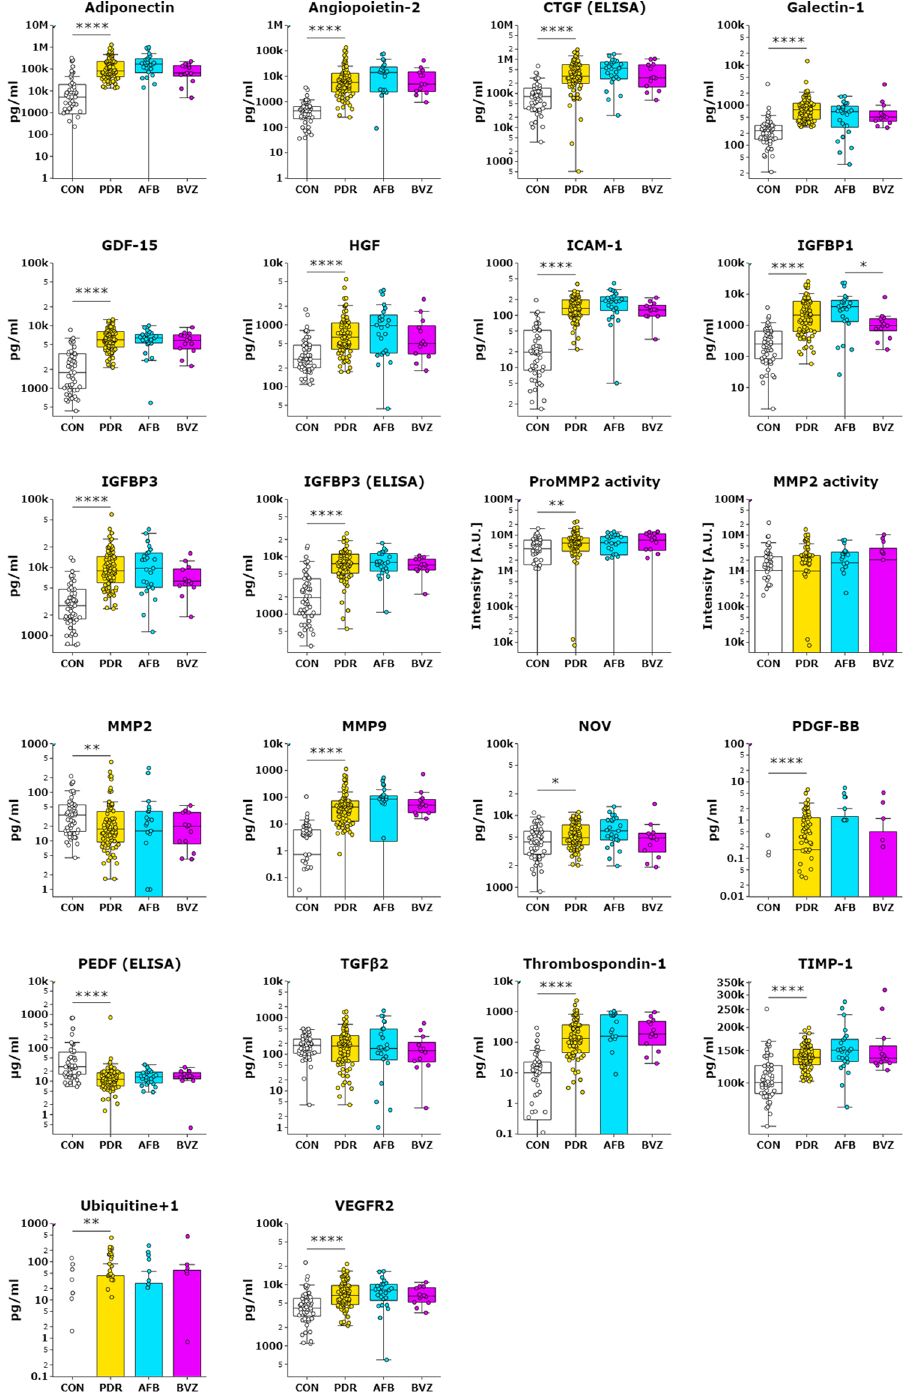
Figure 4. Proteins for which no difference in protein levels was found after anti-VEGF treatment. Box plots indicate median, min and max and 1st and 3rd quartile. Protein concentrations for controls, untreated PDR patients (PDR), PDR patients treated with AFB (AFB) and PDR patients treated with BVZ or RZB (BVZ) are presented in log10 scale. Two proteins are shown as data obtained by ELISA (IGFBP3 and PEDF), activity of ProMMP2 and MMP2 was determined by zymography, all other data was obtained from array analysis. * P < 0.05; ** P < 0.01; *** P < 0.001; **** P <